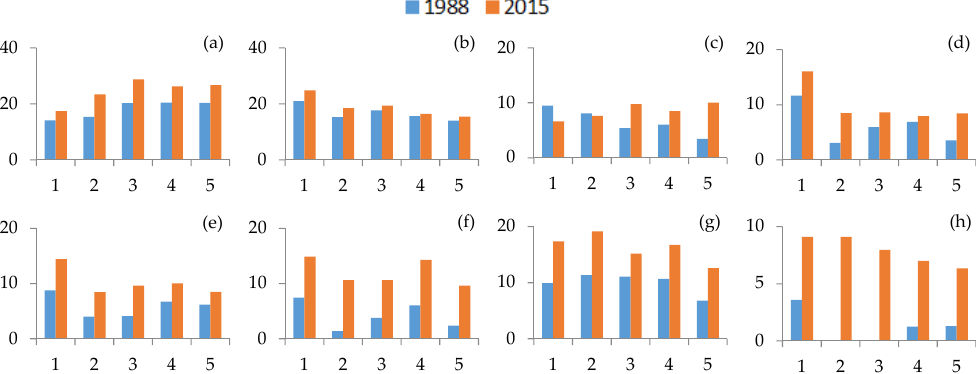
Figure 10. LSIs of the bays in 1988 and 2015. ( a ) Hai Loc Bay; ( b ) Dam Ha Trung Bay; ( c ) Danang Bay; ( d ) Xuan Dai Bay; ( e ) Vinh Van Phong Bay; ( f ) Cam Ranh Bay; ( g ) Ganh Rai Bay; and ( h ) R ạ ch Gi á Bay. Note: The abscissa values are explained as follows: 1: 0–2 km bu ff er; 2: 2–4 km bu ff er; 3: 4–6 km bu ff er; 4: 6–8 km bu ff er; and 5: 8–10 km bu ff